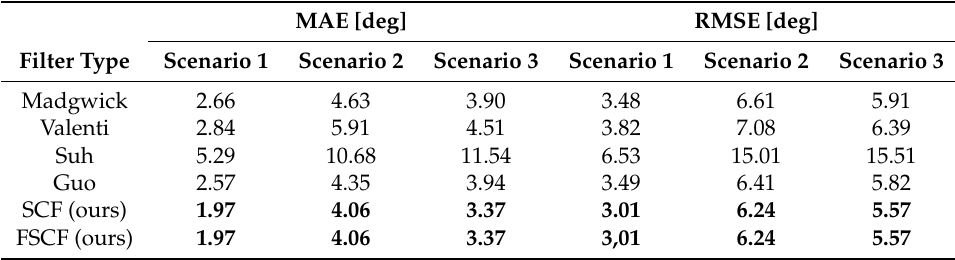
Table 2. Estimation errors of tested filters for all tested scenarios. Parameters of all filters were optimized for the best